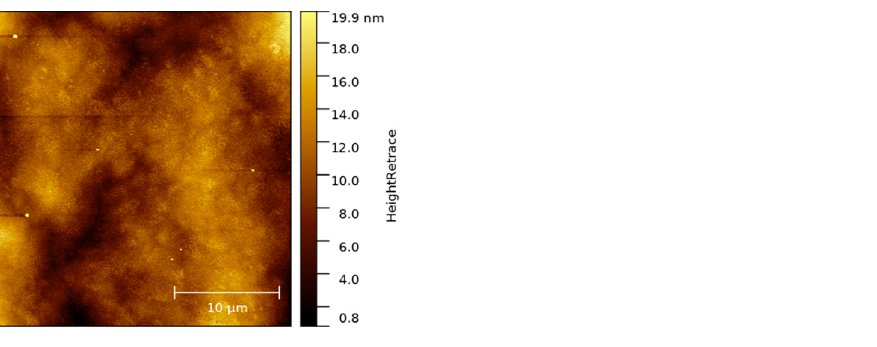
Figure 8. A 25 × 25 µm² overview AFM image of the native surface of as-received p-GaN on silicon.